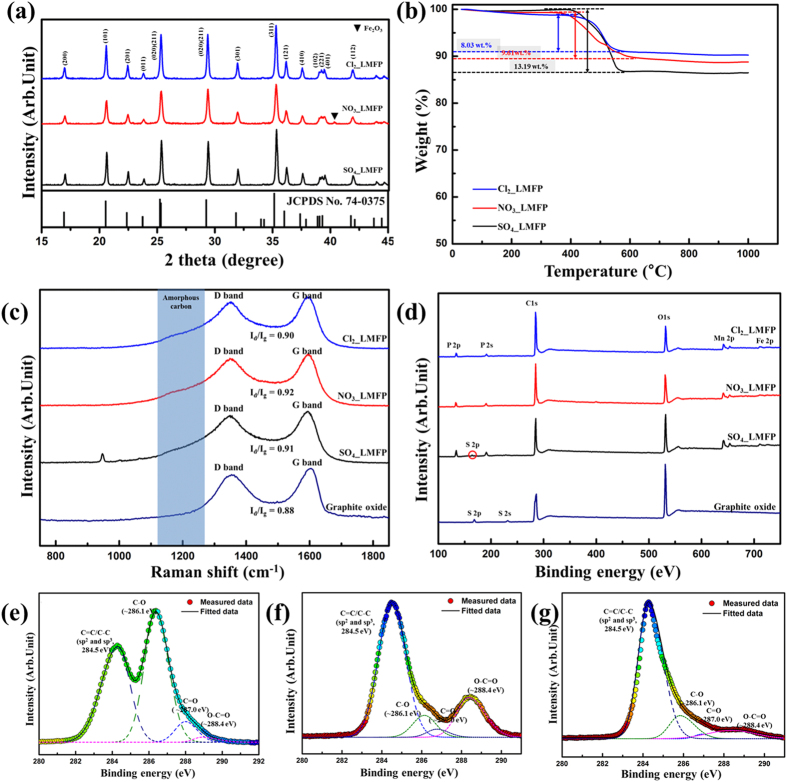
(a) XRD patterns, (b) TGA curves in ambient air, (c) Raman spectra, and (d) full-scale XPS of the 3D LiMn0.75Fe0.25PO4/rGO microspheres synthesized using the different metal salts. XPS C1s spectra of (e) GO, (f) the Li-Mn-Fe-PO4/GO composite precursors, and (g) Cl2_LMFP.